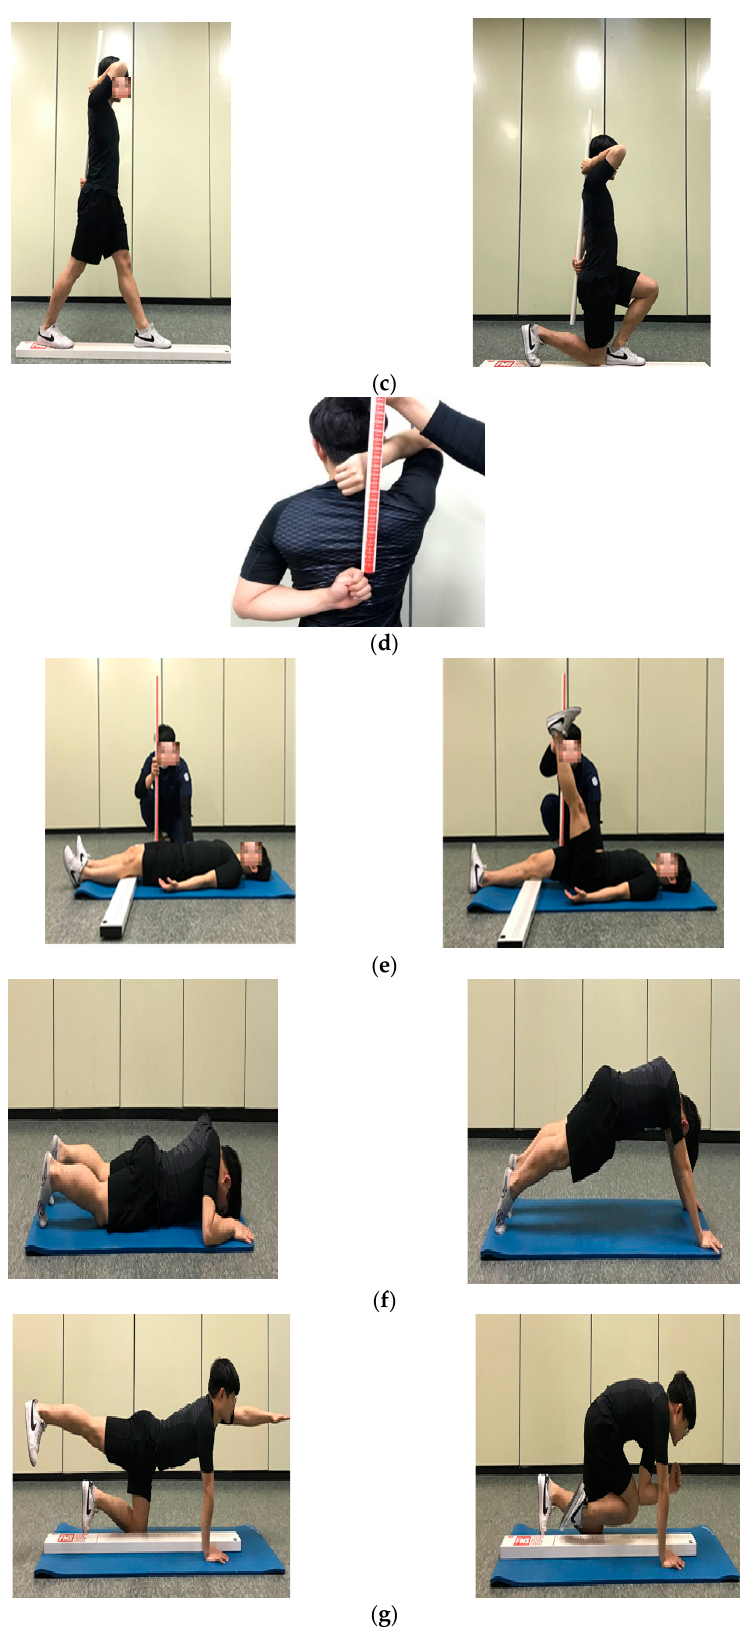
Figure 1. Functional movement screen test: ( a ) deep squat; ( b ) hurdle step; ( c ) inline lunge; ( d ) shoulder mobility; ( e ) active straight-leg raise; ( f ) trunk stability push-up; ( g ) rotary